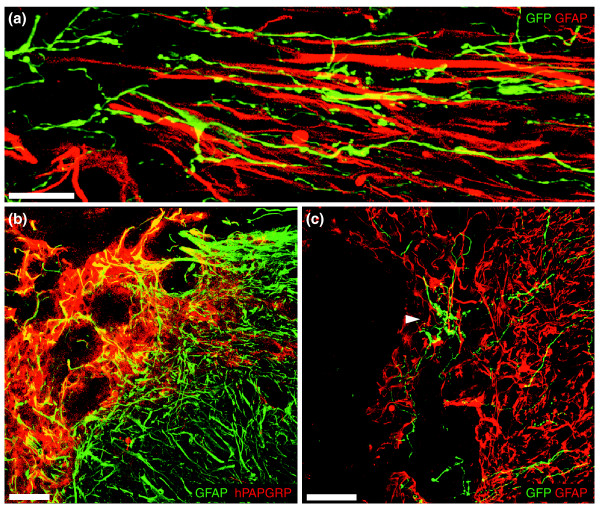
A comparison of GFP+ axon and host astrocyte alignment in GDA- versus GRP- transplanted lesion margins at 8 days after injury. (a) A high-magnification image showing aligned axon growth (green) associated with aligned GFAP+ host astrocytic processes (red) in the caudal margin of a GDA-transplanted lesion. (b) In contrast, GFAP+ astrocytic processes (green) are misaligned in the caudal margin of a GRP-transplanted lesion (red). (c) A high-power confocal image showing GFP+ axons displaying tortuous, misaligned patterns of growth and dystrophic end bulbs (arrowhead) within the astrogliotic caudal margin of a GRP-transplanted lesion. Scale bars: (a) 25 μm; (b,c) 50 μm.